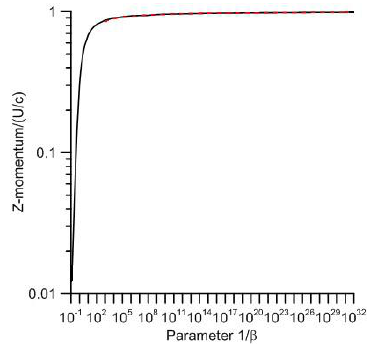
Figure 4. The variation of the ratio of z -momentum to U / c as a function of 1/ β . The solid line is calculated using Equation (24) and the dashed line by using Equation (29).